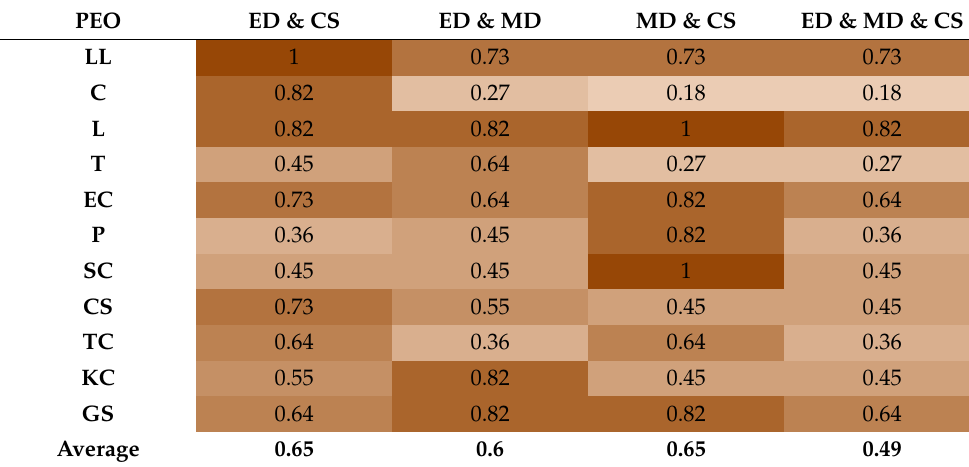
Table 9. Computed agreements between similarity measures.